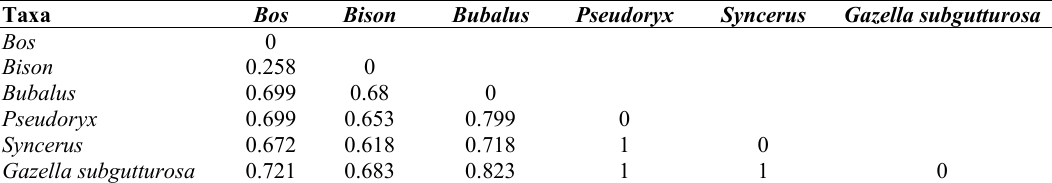
Table 7. Pairwise F based on the complete mitochondrial genomes between different genera belonging to the ST tribe